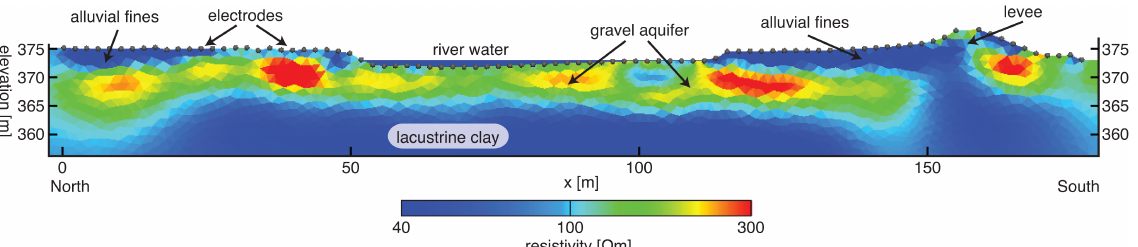
Fig. 4. Electrical resistivity model crossing the Thur River at right angles in the vicinity of the pumping-station transect (transect A in Fig. 2). The moderately resistive gravel deposits (green and red) can be distinguished from the overlying more conductive loamy topsoil (blue) and the underlying lacustrine clays (blue). Low porosity regions within the gravel deposits (red) can also be